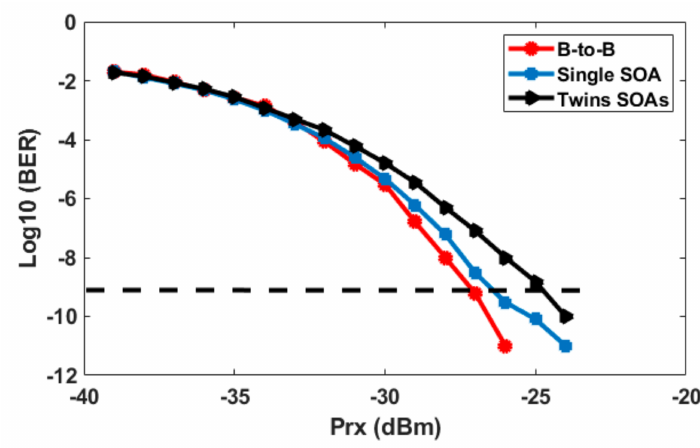
Figure 12. Experimental NRZ BER measurements in back-to-back configuration compared to single SOA BER and twin parallel SOAs.